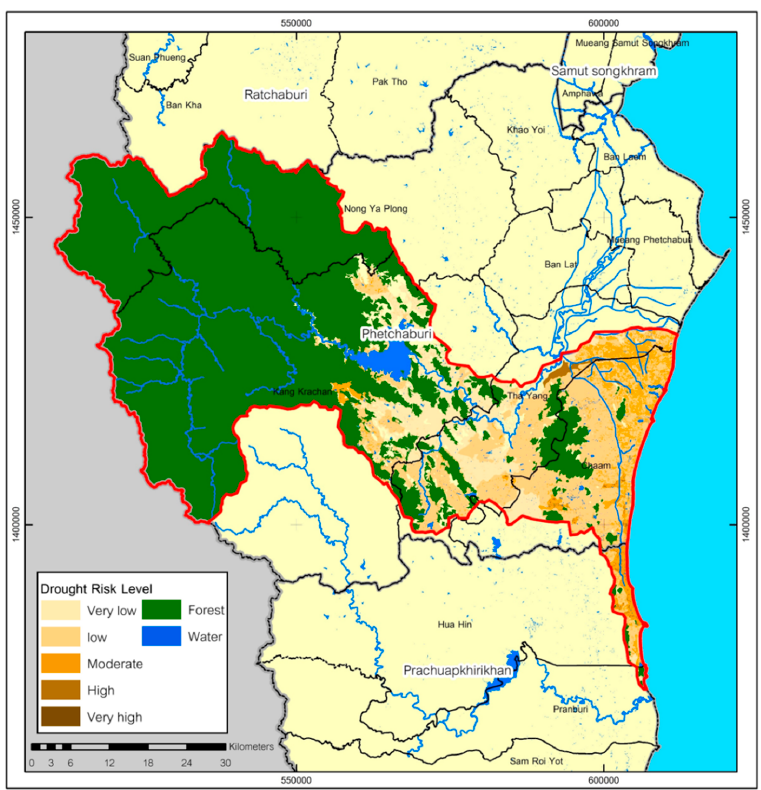
Figure 4 . The area of drought risk in UPRB . Figure 4. The area of drought risk in